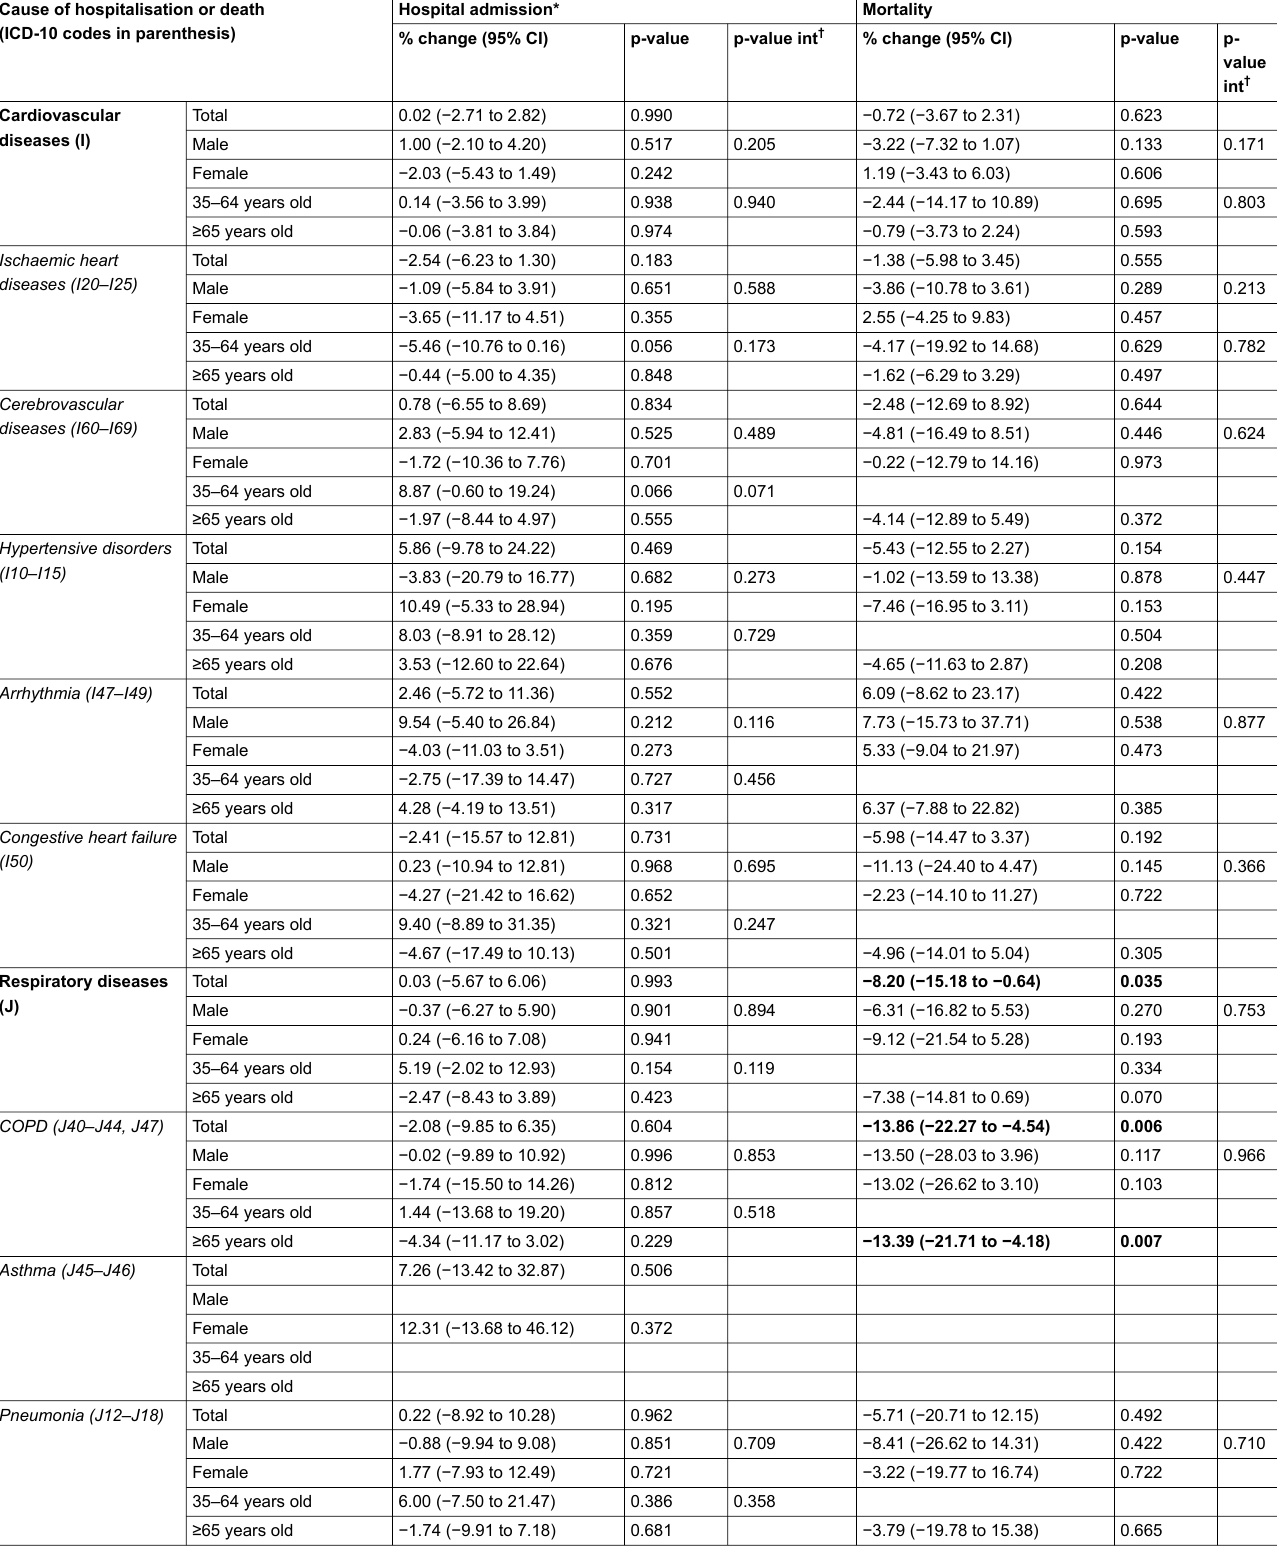
Table S4: Gender- and age-specific percent estimates (and 95% confidence interval) in change in hospital admissions and mortality in adults (≥35 years old) due to the main groups of causes after the introduction of the smoking ban (data restricted to the period including 2 years before and 2 years after the introduction of the smoking ban in each canton). Results are displayed in figure 2